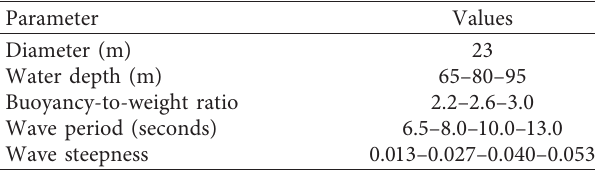
Table 1: Summary of the experimental